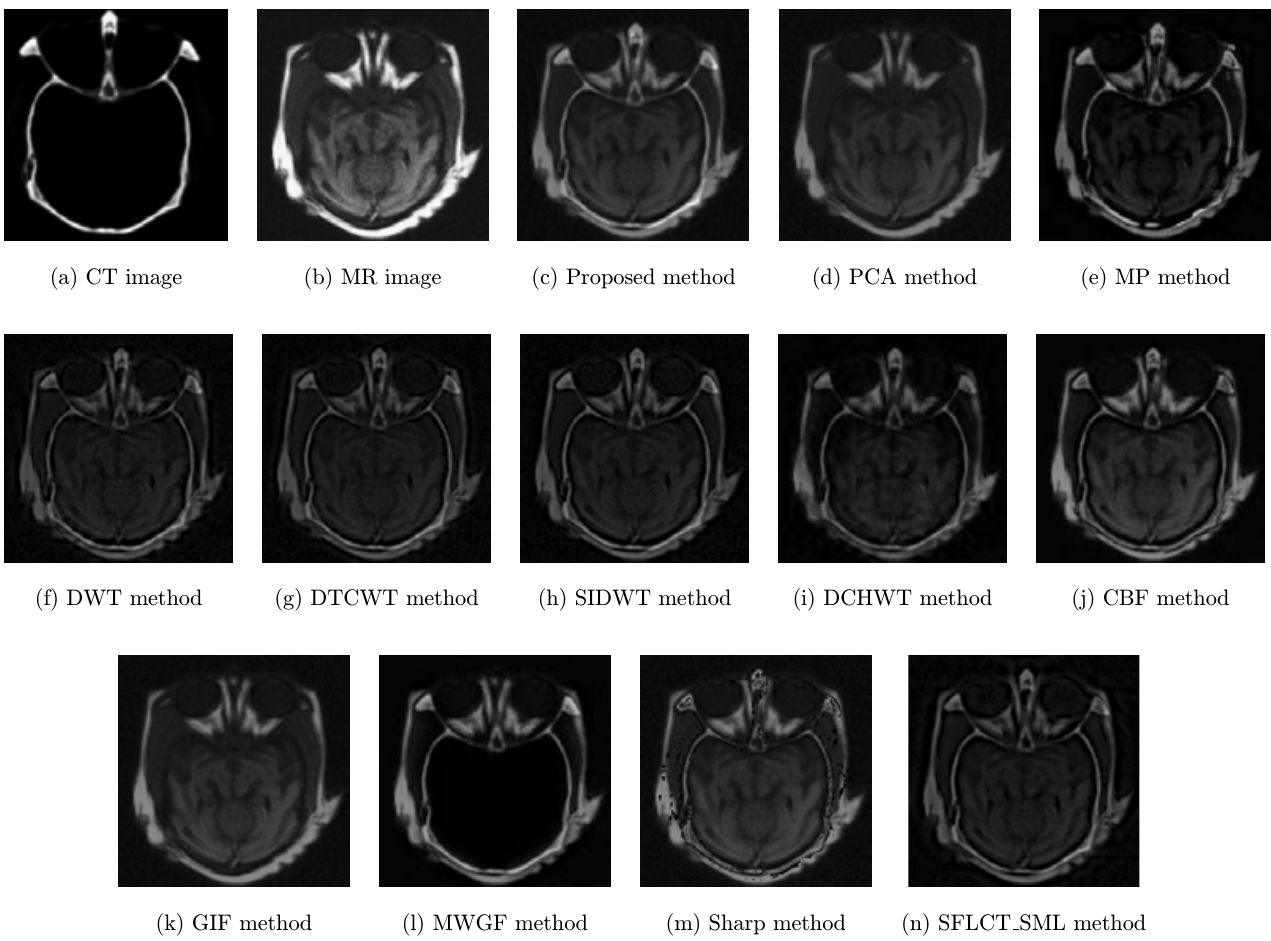
Fig. 3. Fused images for the ¯rst group of medical